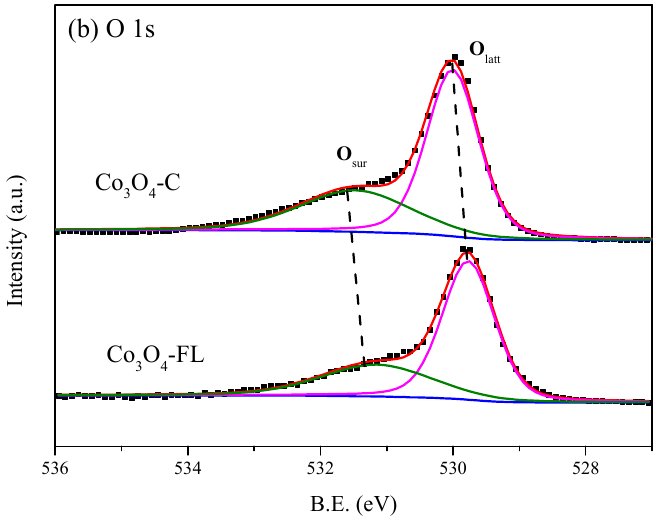
Figure 5. ( a ) Co 2p and ( b ) O 1s XPS spectra of the Co 3 O 4 -FL and Co 3 O 4 -C catalysts. Based on the quantitative analysis, the Co 2+ /Co 3+ molar ratio of the two catalysts was Co 3 O 4 -FL (1.46) > Co 3 O 4 -C (1.31). The higher molar ratio of Co 2+ /Co 3+ than Co 3 O 4 -FL indicates that a higher abundance of Co 2+ cations was presented on the surface of Co 3 O 4 -FL, which could manifest an increased redox activity for methane oxidation [28]. This trend